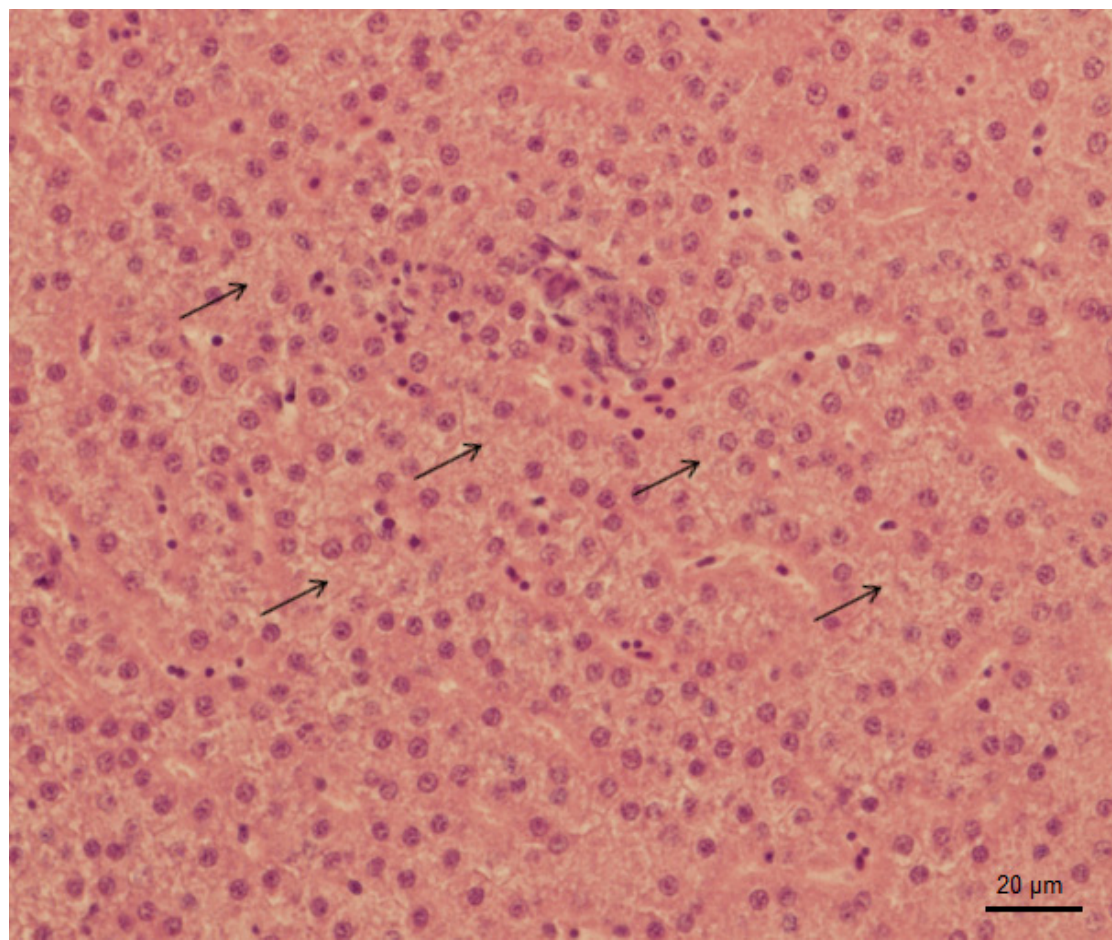
Figure 1. Abnormal glycogen accumulation in liver of Danio rerio after exposure to 600 µg/L of tramadol hydrochloride (hematoxylin and eosin, 400x).